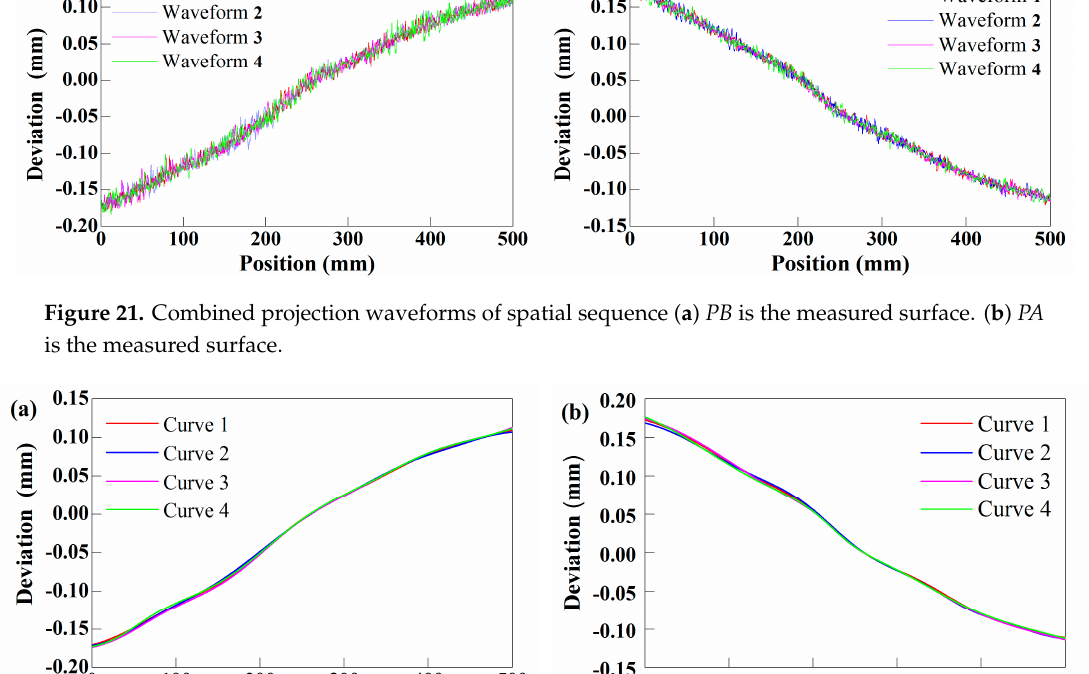
Figure 20. Amplitude corresponding to frequency 2 Hz, 4 Hz, 6 Hz, 8 Hz. ( a ) PB is the measured plane ( b ) PA is the measured plane.